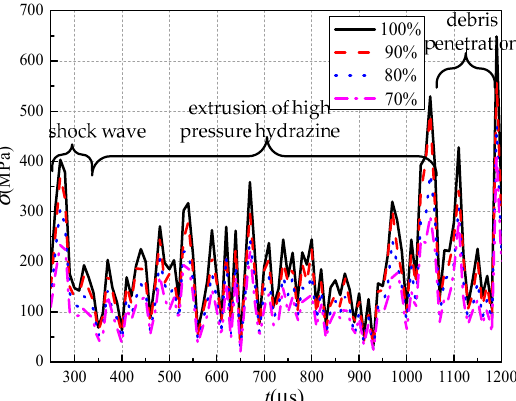
Figure 11. Stress–time curves of element H on the front wall with liquid-filling ratios of 70%, 80%, 90%, and 100%.